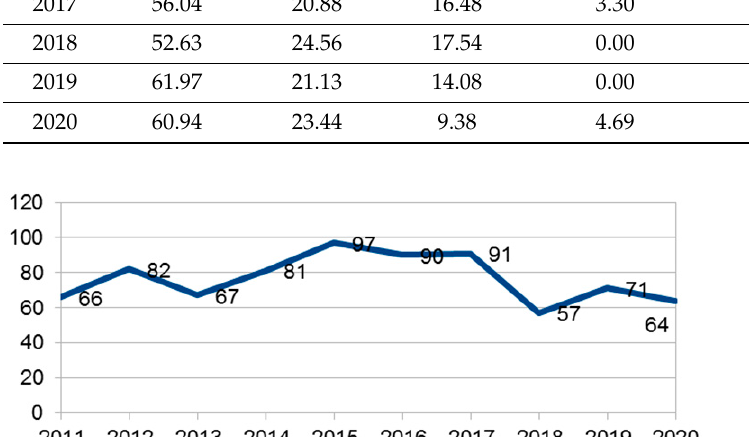
Figure 2. Proportion of hearing loss by age.